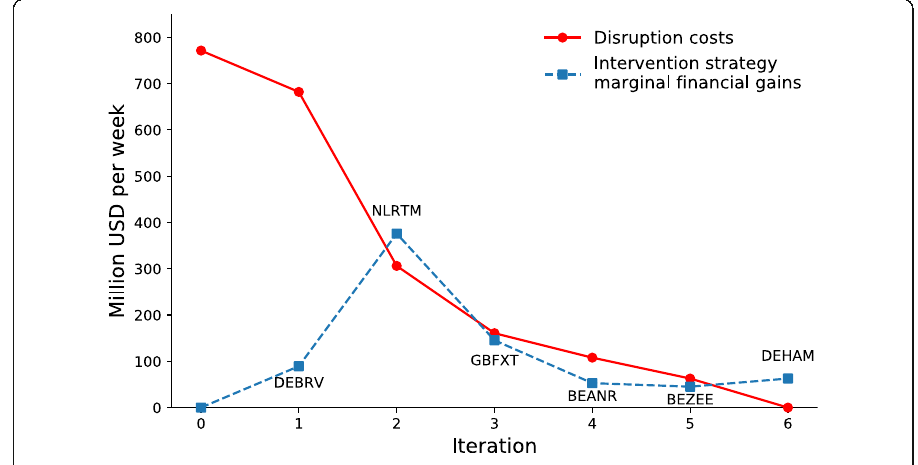
Fig. 4 Disruption costs and intervention financial